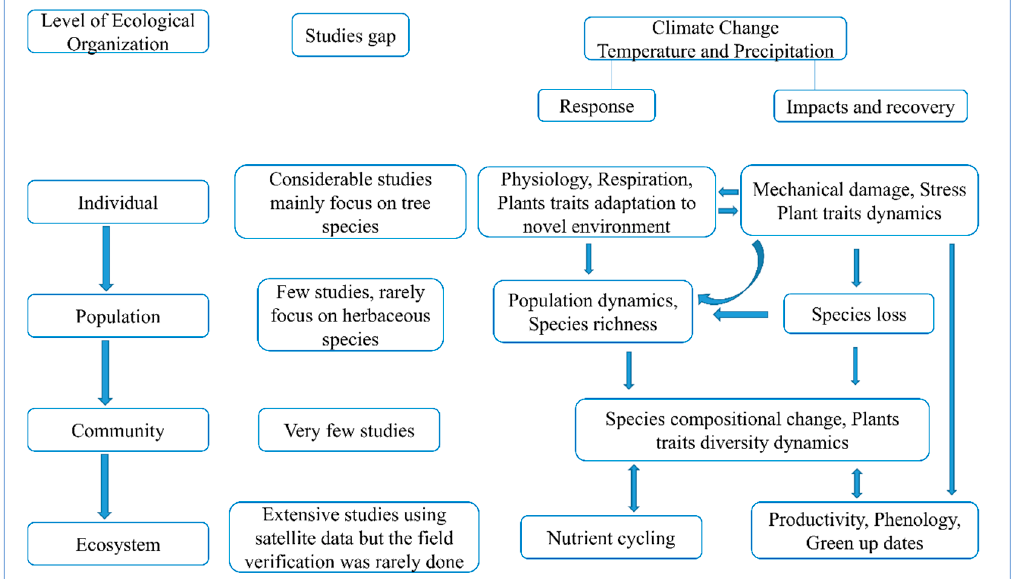
Figure 1. Conceptual diagram of the climate change impact and plant response across different ecological levels along with the research gap in the Tibetan Plateau. Initially, climate has a physiological or mechanical impact on individual plant species, which interact across multi-scale ecological organizations.